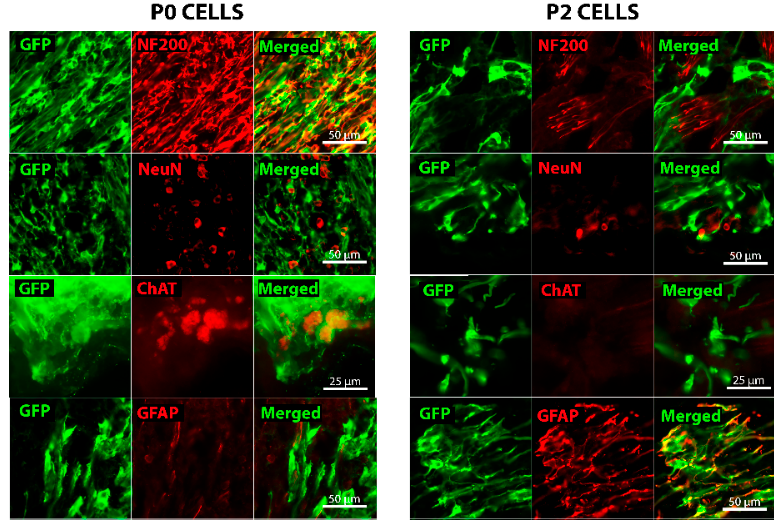
Figure 2. Surviving GFP (Green fluorescent protein)-expressing cells (green) can be seen on longitudinal sections of the musculocutaneous nerve taken from the 6-week time point. The left panels are representative for the P0 cell graft while the right panels for P2 cell graft. Grafted P0 fetal cells seem to have retained their neuronal identity, expressing NF200 (red) and NeuN (red), with some ChAT positive cells (red) detected as well. In contrast, grafted P2 NPCs have mostly differentiated into GFAP (red) expressing astrocytes. However, a few NeuN-positive cells (red) and NF200-positive axons (red) can also be seen even though their GFP expression is really low.